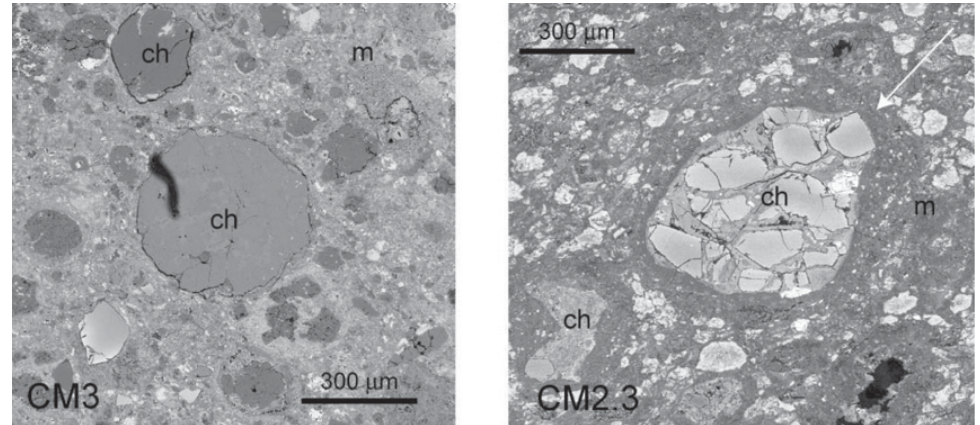
Figure 1. SEM images of two CM chondrites showing different level of aqueous alteration. On the left, in the case of the CM3 chondrite, the chondrule (ch) is not altered, and the contact with the matrix (m) is sharp. On the right, the meteorite is more altered (CM 2.3), and there is a rim around the chondrule (white arrow). This rim is due to the alteration of the chondrule, and contains altered phase, like the matrix. The matrices are different; the CM 2.3 contains more carbonates, magnetite and phyllosilicates than the